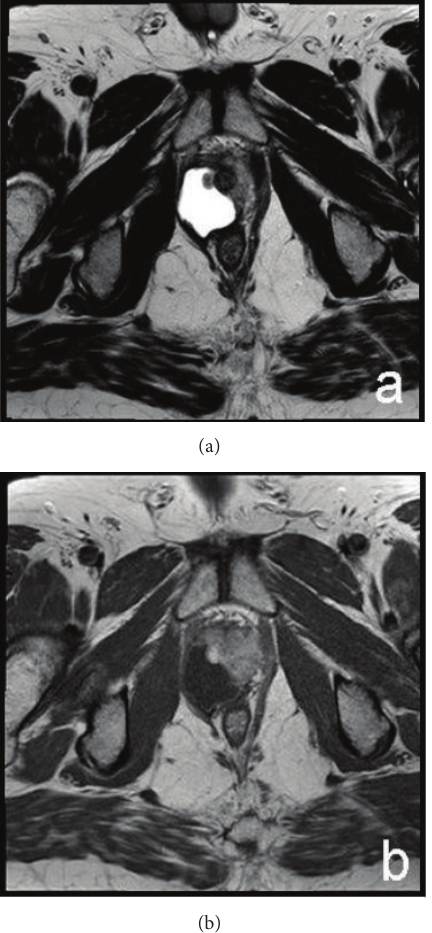
Figure 6: MRI. Postoperative images. Axial T2-weighted (a) and T1-weighted after contrast administration (b) images. Persistence of synovial sarcoma in the prostatic